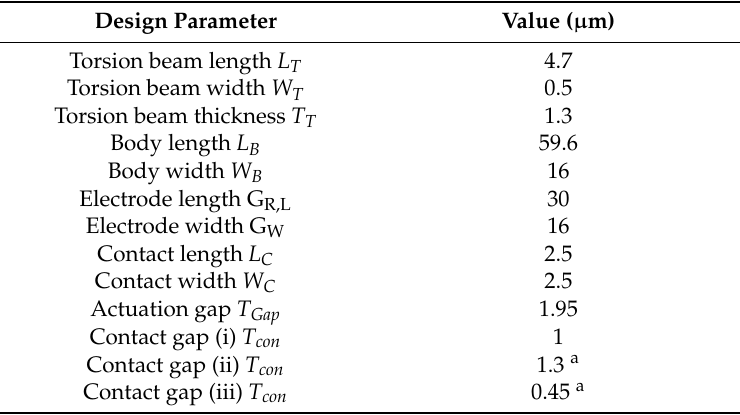
Figure 1. ( a ) 3D schematic of the designed seesaw relay including cross-sectional views (red lines). ( b ) Cross-section A1–A2 along the length of the relay, the gate electrodes are defined with MET1 and VIA1. ( c ) Cross-section A3–A4 at the contact area of the relay (between Source and Drain) with the three possibilities: (i) Type I, (ii) Type II, and (iii) Type III. Table 1. Seesaw relay design parameters and their values.